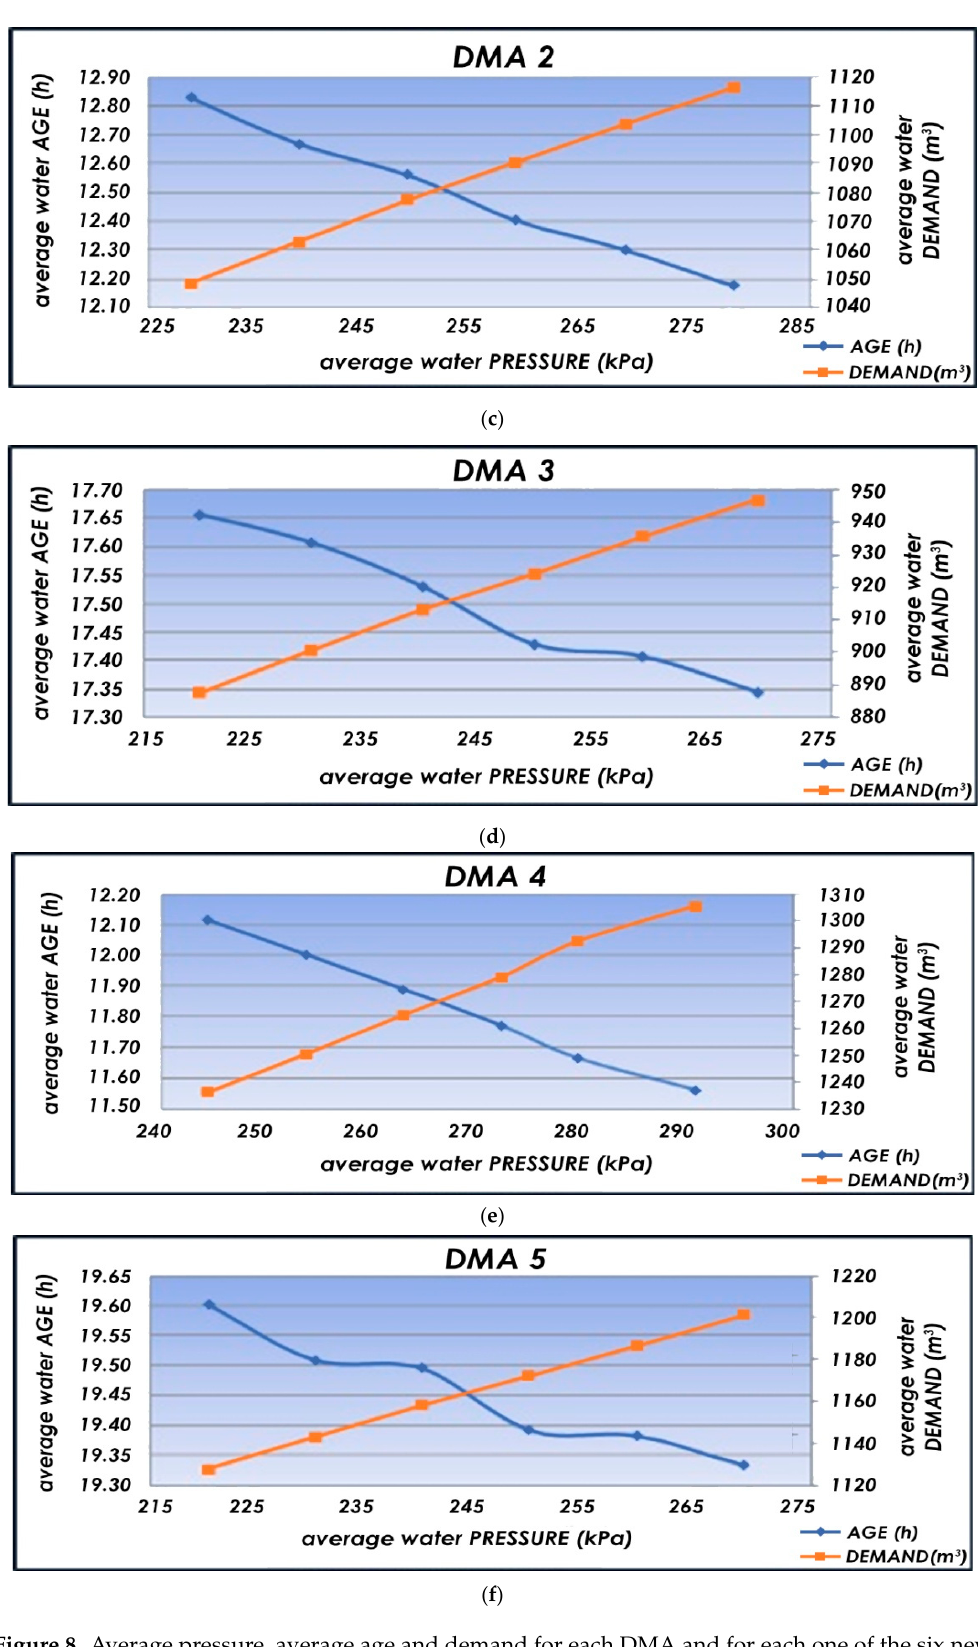
Figure 8. Average pressure, average age and demand for each DMA and for each one of the six new cases ( a–f ).